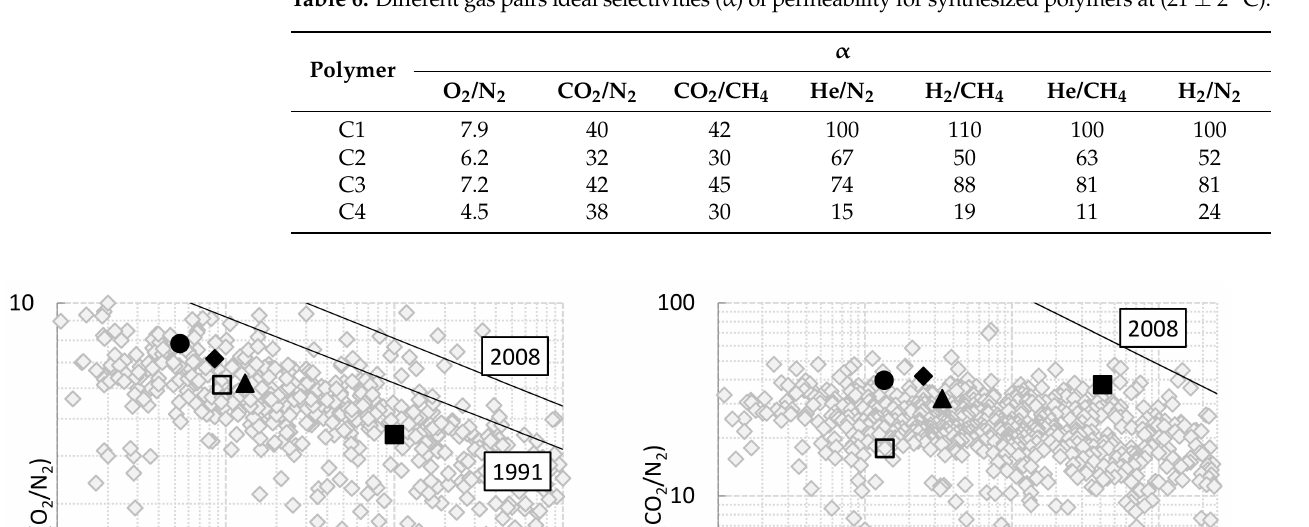
Table 6. Different gas pairs ideal selectivities ( α ) of permeability for synthesized polymers at (21 ± 2 ◦ C).